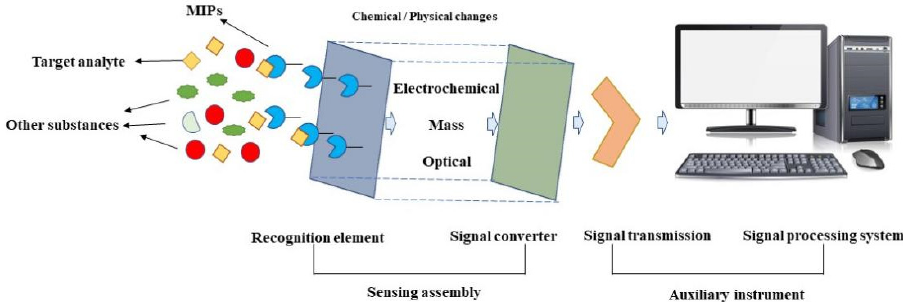
Figure 3. Fundamental construction and principle of MIP-based sensors. Adapted from Ref. [62].